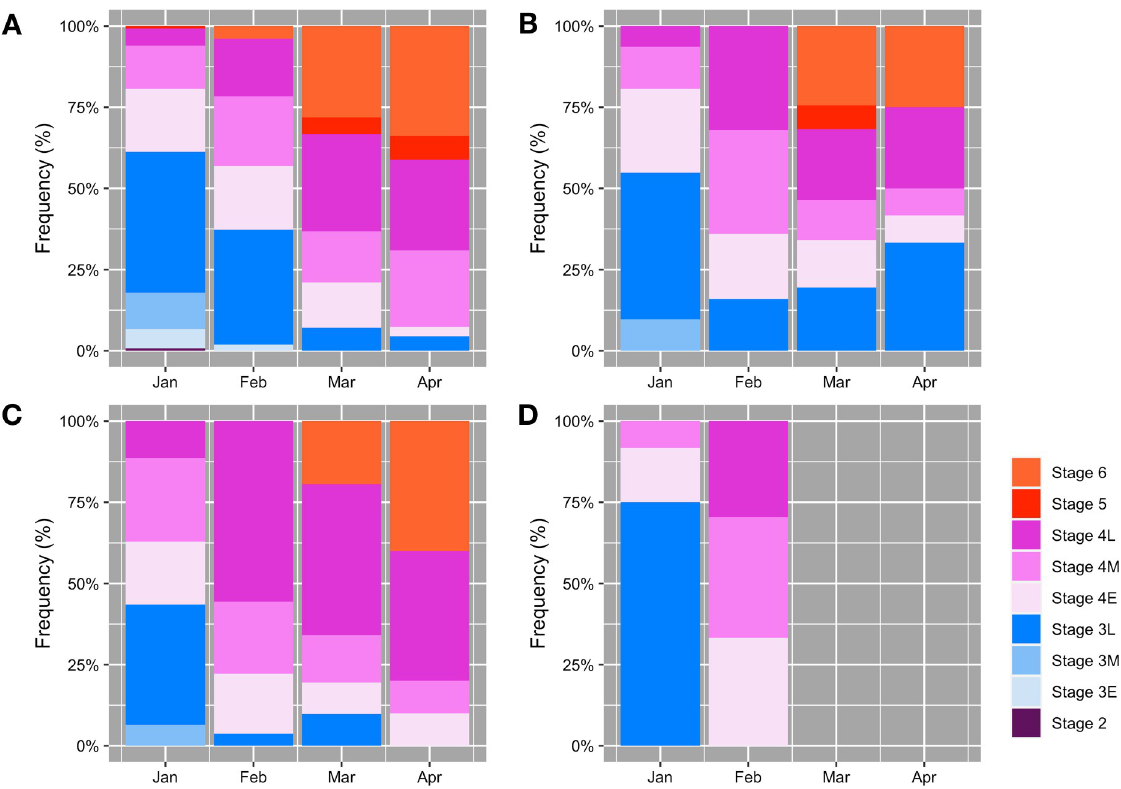
Fig 4. Monthly changes of female Delta Smelt maturity levels for 2011–2014 year-classes. Months with extremely low catches (n < 5) are not depicted in the figure (i.e., March and April in the 2014 year-class; Panel D).